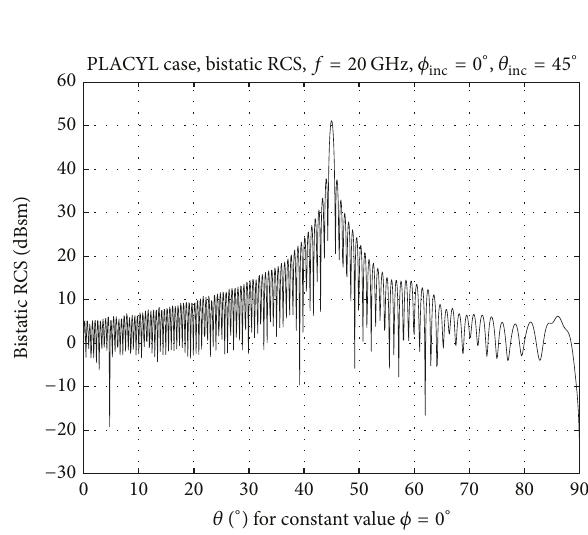
Figure 4: Bistatic RCS results of the PLACYL case, 𝑓 = 20 GHz.